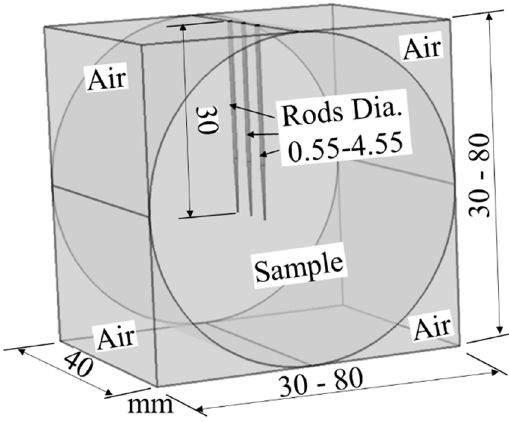
Figure 3. Transparent view of a 3D numerical model for computing the electrical potential field surrounding the TDR probe. The unit of the dimensions of the model is mm.